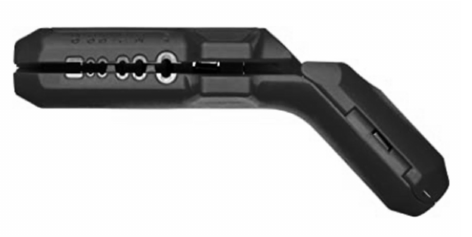
Figure 2. Cable stripping tool used to artificially damage the analyzed